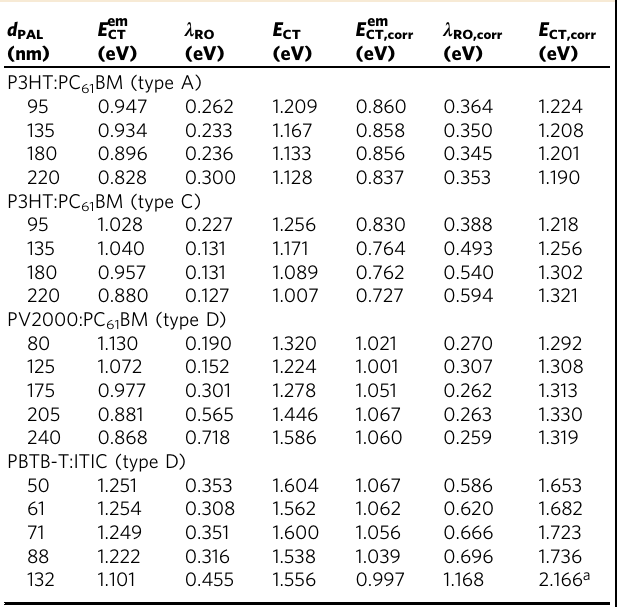
Table 1 Results of Gaussian fi ts to the experimental and corrected reduced EL spectra for different photoactive materials and varying absorber thickness d PAL plotted in Fig.